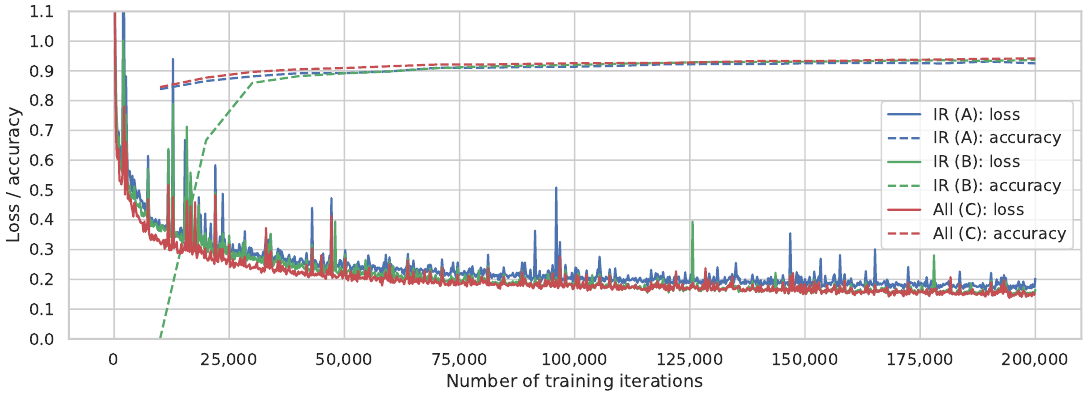
Figure 4. Training loss and accuracy for all three model variations.